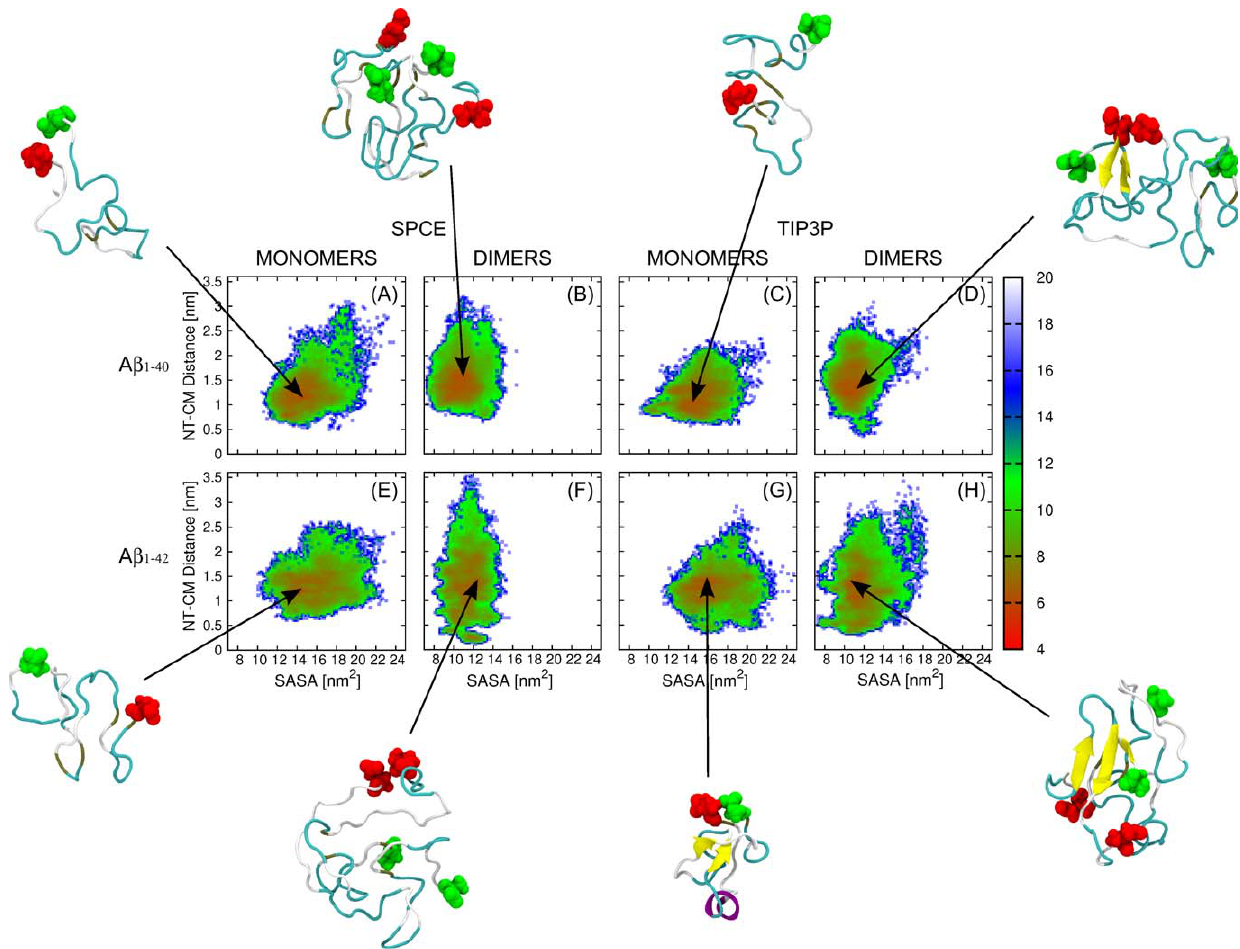
Figure 3. Free energy landscapes of A b monomers and dimers with representative conformations. The reaction coordinates are the SASA of all hydrophobic amino-acids (x-axis) and the NT-CM distance (y-axis). The PMF plots for (A,C) A b 1 { 40 and (E,G) A b 1 { 42 monomers were acquired by MD using the (A,E) SPCE and (C,G) TIP3P water models. The corresponding PMF plots for (B,D) A b 1 { 40 and (F,H) A b 1 { 42 dimers were acquired by MD using the (B,F) SPCE and (D,H) TIP3P water models. The color scheme to the right of each plot is given in units of k B T. The representative conformations of each conformational ensemble are displayed with the N-terminal amino acid D1 colored red and the C-terminal amino acid (V40/A42) colored green. The images were generated by VMD.